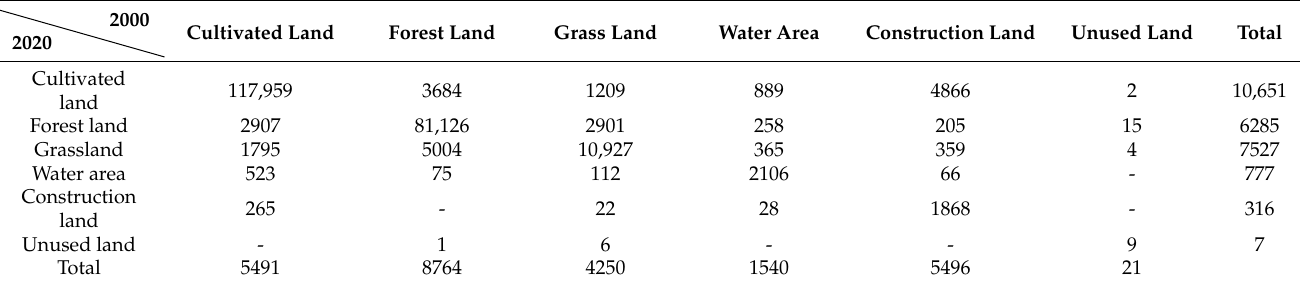
Table 1. Land use landscape transfer matrix from 2000 to 2020 (km 2